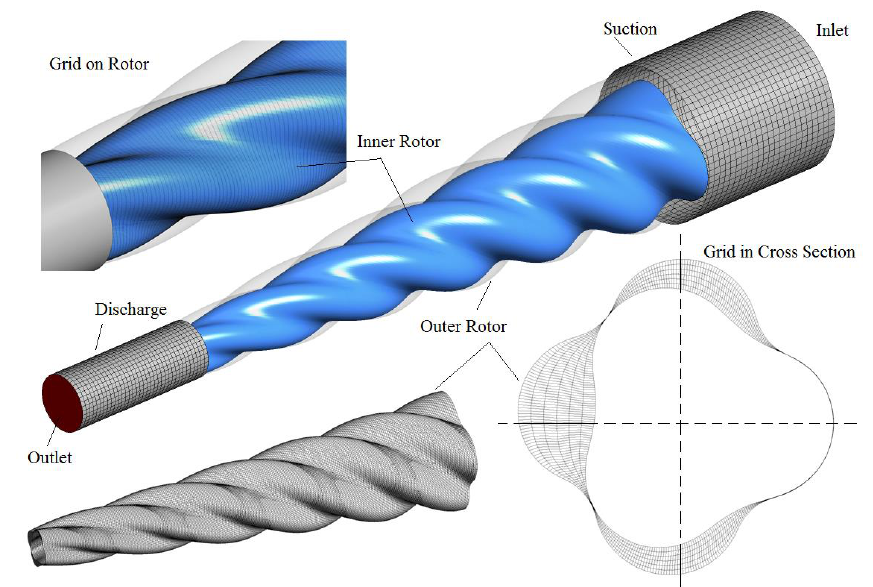
Figure 11. Grid of the working chamber of conical internally geared screw rotors ([1], Video S4).